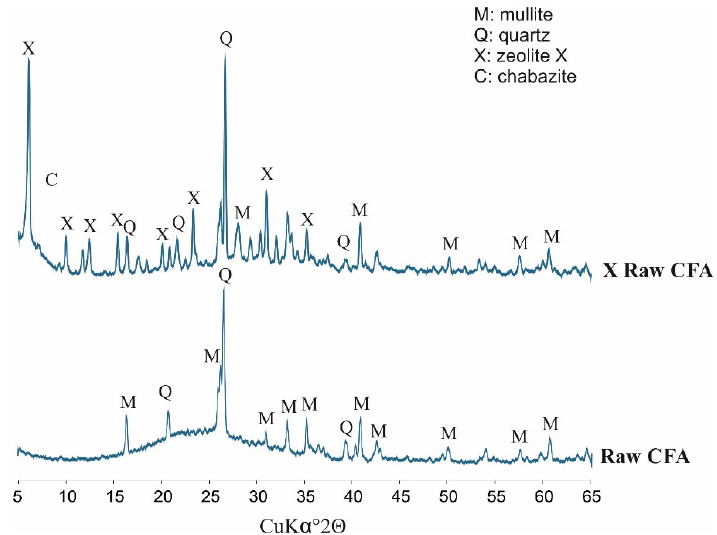
Figure 3. Phase analyses of raw CFA (coal fly ash).